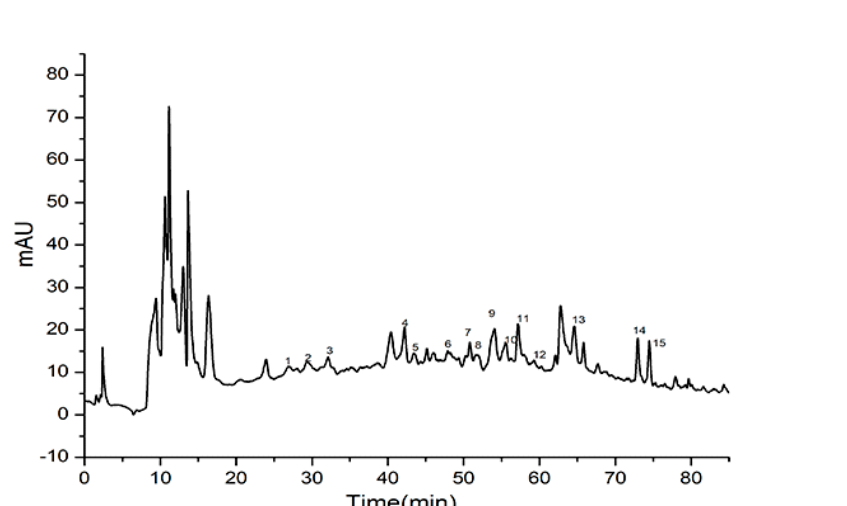
Figure 3. HPLC chromatograms of the major phenolic acid compounds in the vinasse extract. Peaks 1–3 are dimer ferulic acid. Peaks 4–6 are vanillic acid, chlorogenic acid, and syringic acid, respectively. Peaks 7–9 are sinapic acid, p -coumaric acid, and caffeic acid, respectively. Peaks 10–12 are syringic acid + HC OO H. Peak 13 is ferulic acid. Peaks 14–15 are 8’-5’-DiFA.